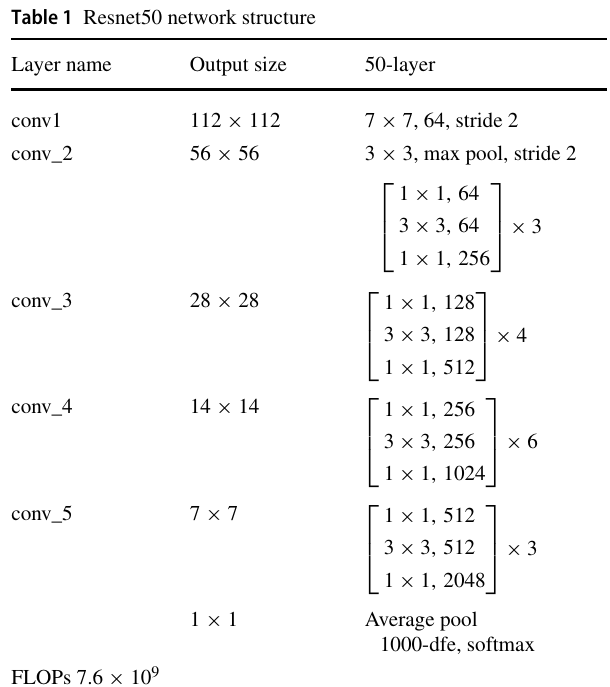
(a) General Network (b) Residual Network